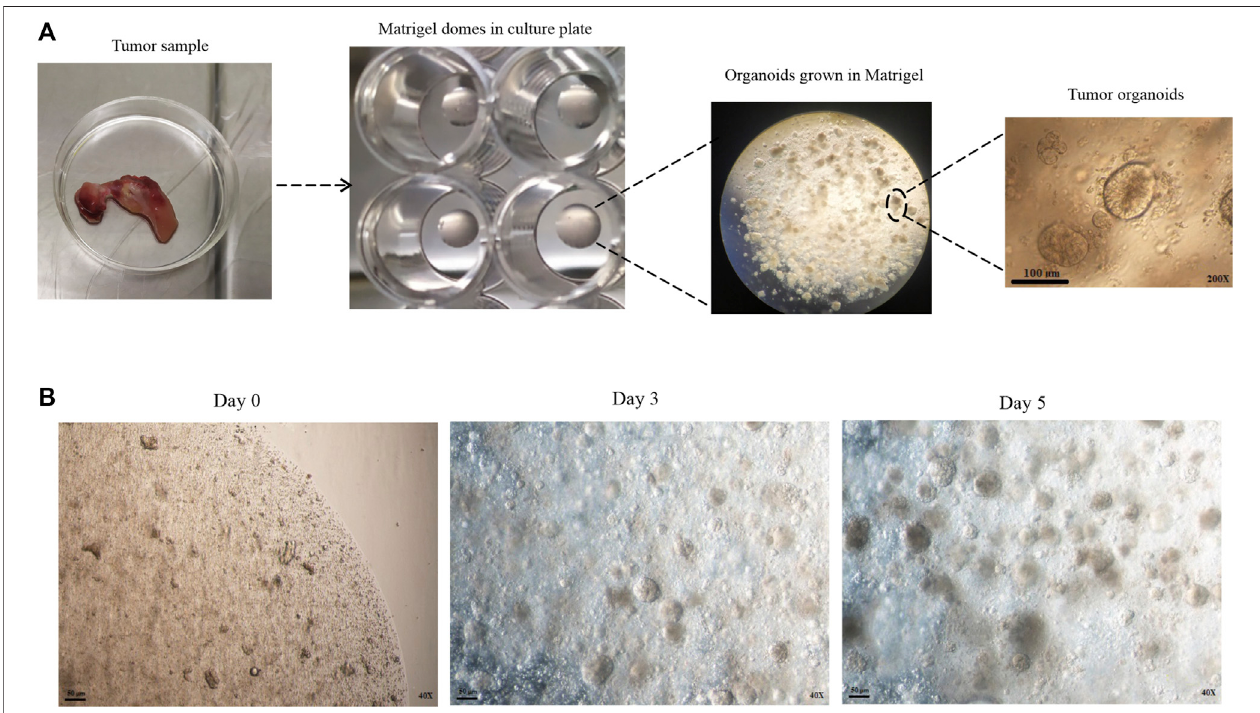
FIGURE 1 | Development of patient-derived colon cancer organoid. (A) Tumor samples were taken from the patient. After tissue digestion, the cells and crypts wereseeded with Matrigel in a48well plate. Afteradding theorganoid culture medium totheMatrigeldome, the three-dimensional structure of theorganoids isformed. (B) Different time intervals of organoids in the culture